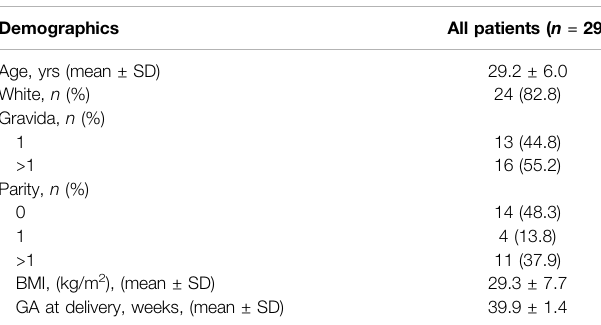
TABLE 1 | Study population